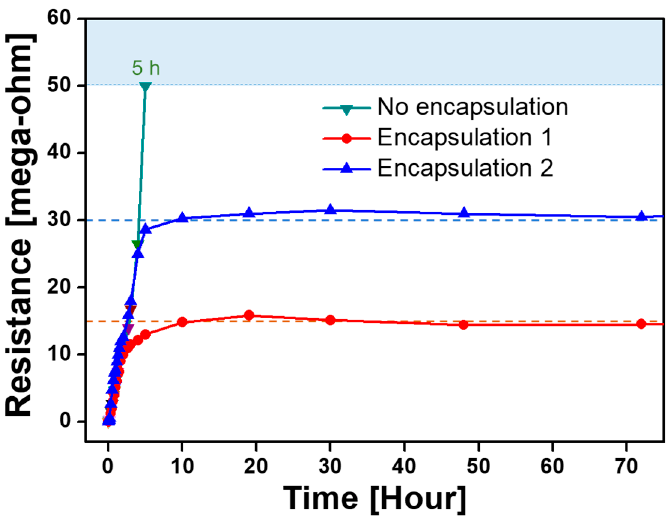
Figure 10. Changes in the electrical resistance of I 2 -doped PANI films subjected to different encapsu- lation processes over three days. Encapsulation process examined with PANI films polymerized with N 2 gas added